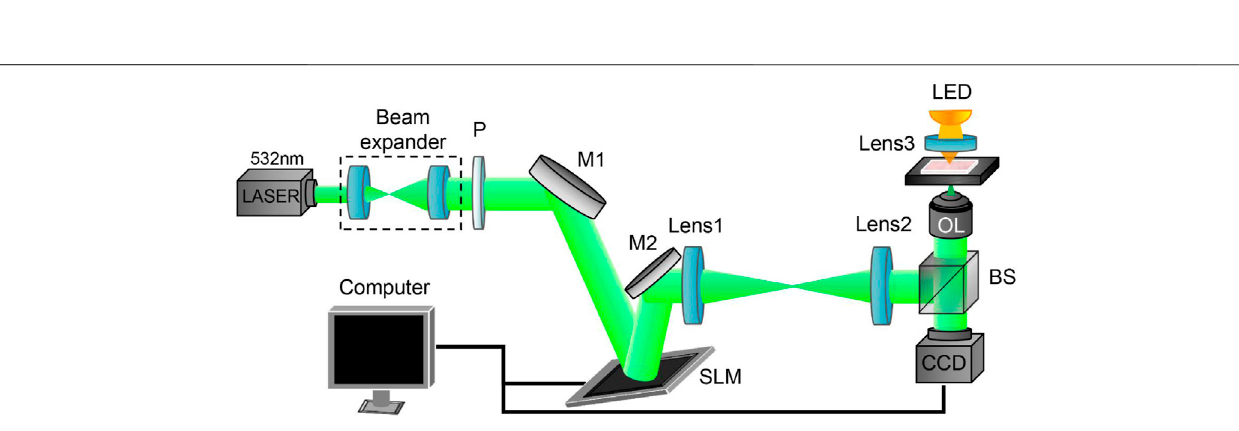
Frontiers in Physics |